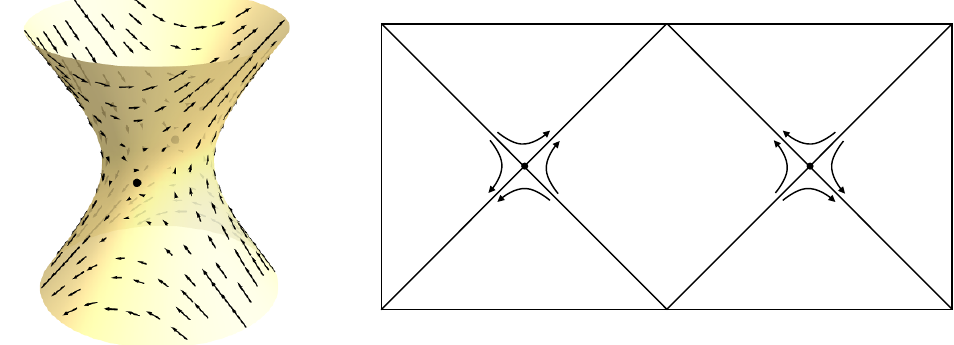
Figure 5 . Kinematic space is a particular coadjoint orbit of SO(2 ; 1) given by the two-dimensional de Sitter hyperboloid, depicted here on the embedding diagram (left) and Penrose diagram (right) for dS 2 along with the boost (3.25). Characters of the principal series representations can be com- puted geometrically from sums over the two (cid:12)xed points of this boost using the Atiyah-Bott formula. The Hamiltonian, h , corresponding to i@ (cid:17) is de(cid:12)ned